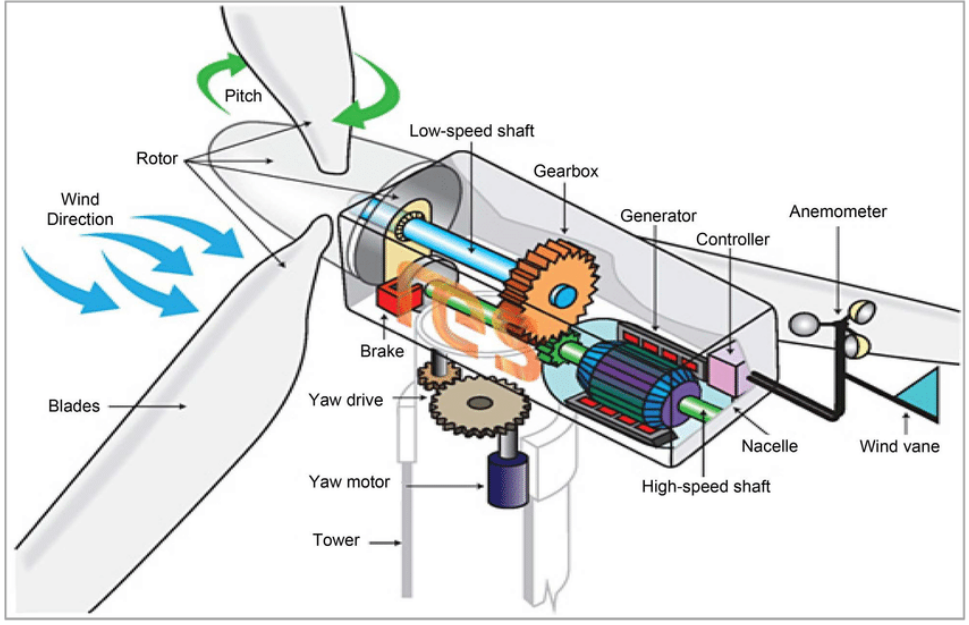
Figure 1. Wind Turbine components scheme [28] (the figure was originally provided by U.S. Depart- ment of Energy, accessed on 9 December 2021